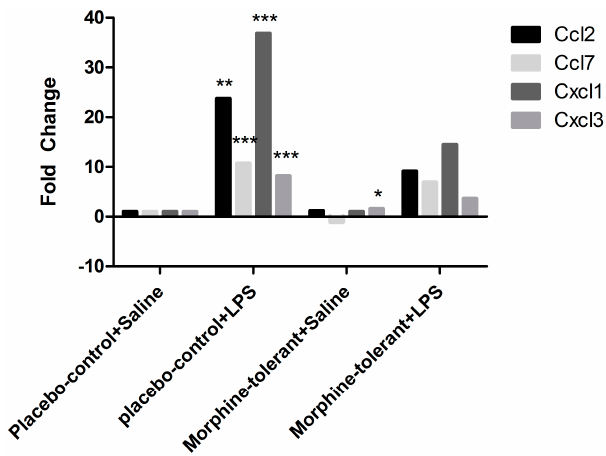
Figure 3. Cytokine gene expression in the rat brain in response to lipopolysaccharides (LPS), with and without morphine tolerance. Gene expression of interleukins Interleukin (Il)-1 β , Il-6, Il-12a, Il-12b, Il- 18, and Il-33 in the brains of rats, with and without morphine tolerance, following an i.p. injection of either 250 µg/kg LPS or saline ( n = 3–5 rats per group) was determined using a Polymerase Chain Reaction (PCR) array. Data were calculated using the ΔΔ CT method relative to the control group (placebo-control + saline) and are represented as a fold change. * p < 0.05, ** p < 0.01, *** p < 0.001